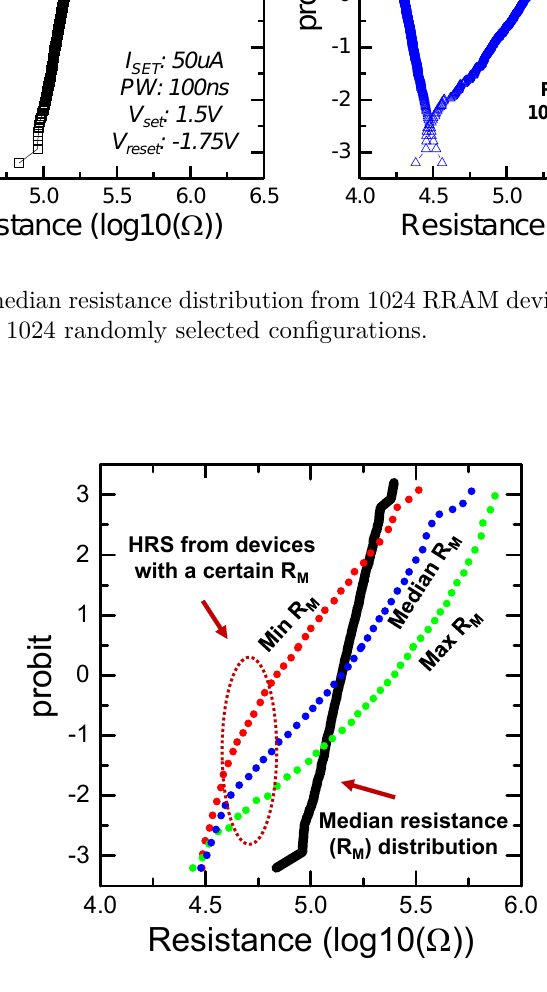
Figure 11: The HRS distributions from the devices with the min/max and median of the median resistance. With a fixed threshold, the probabilities to produce “1” and “0” show large deviations between each devices, which disprove the reconfigurability of this